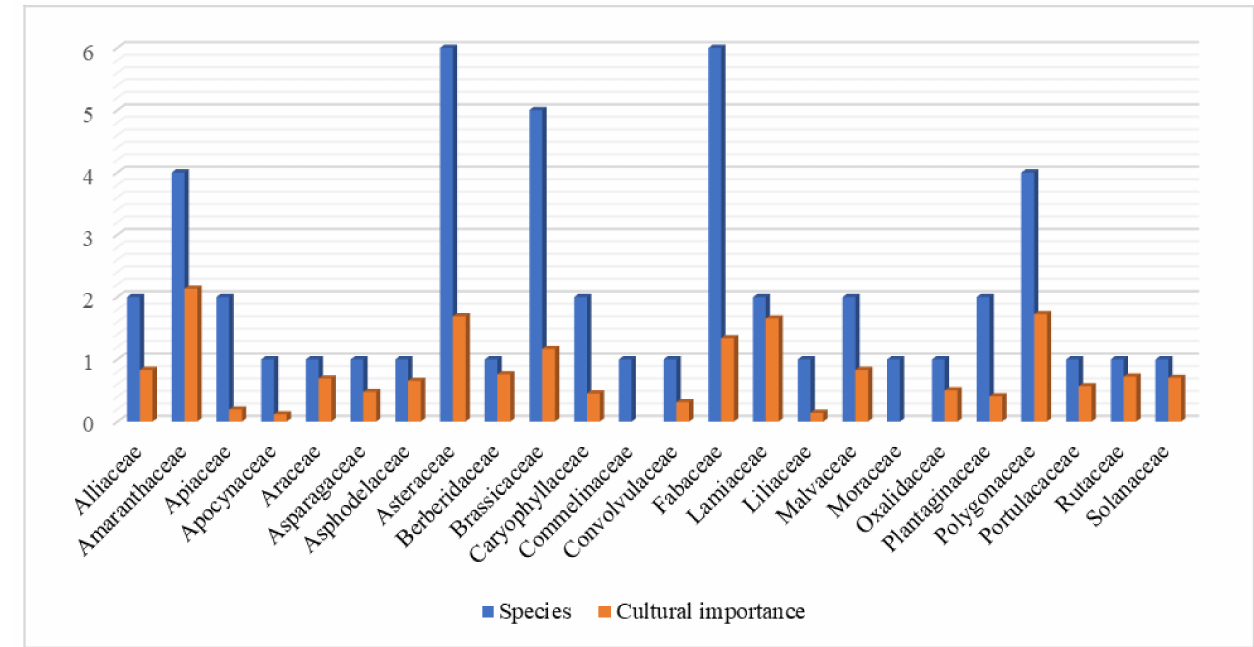
Figure 9. Cultural importance of quoted botanical